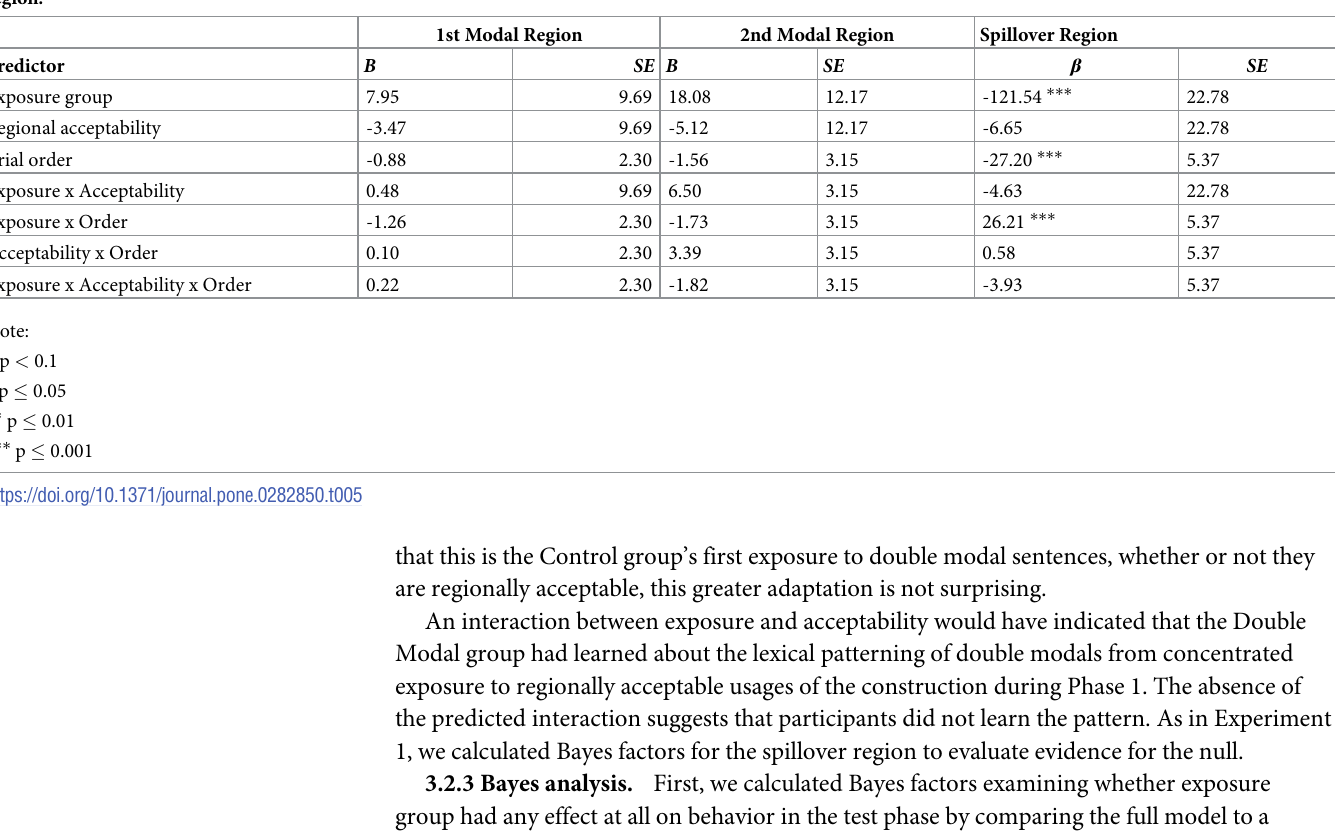
Table 5. Experiment 2 test block fixed effects summary for the three regions of analysis: The 1st modal region, the critical 2nd modal region, and the spillover